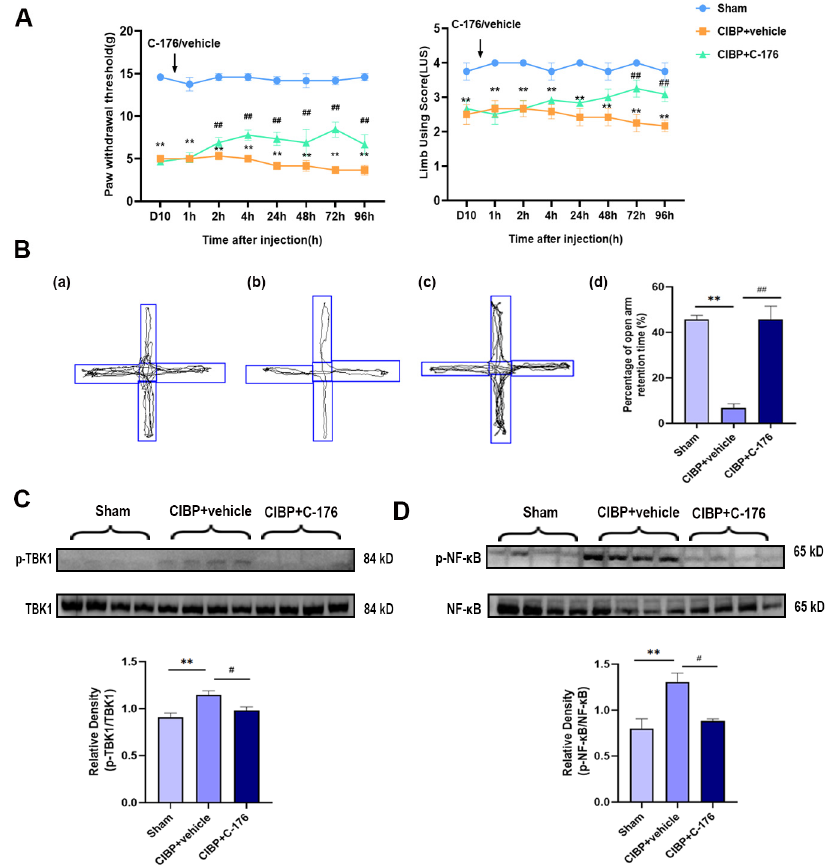
Figure 3. C-176 treatment relieved pain and pain-related anxiety by inhibiting the TBK1-NF- κ B signaling pathway in the mPFC of CIBP rats. ( A ) Compared with vehicle (corn oil, 200 µ L, i.p.), injection of C-176 (5.25 µ mol in 200 µ L corn oil, i.p.) significantly decreased the level of the paw withdrawal threshold (PWT) (Left) and limb use score (Right) of CIBP rats. ( B ) The tracks and analysis of elevated plus-maze experiment. Representative activity traces of sham ( a ), CIBP + vehicle ( b ), and CIBP + C-176 ( c ) in the elevated plus-maze experiment are shown. ( d ) Percentage of open arm retention time was analyzed’, n = 3. ( C ) The protein expression of the rate of p-TBK1/TBK1 in sham, CIBP + vehicle, and CIBP + C-176 group were determined using Western blots. ( D ) The protein expression of the rate of p-NF- κ B/NF- κ B in sham, CIBP + vehicle, and CIBP + C-176 group were determined using Western blots. GAPDH was detected as an internal control. Data are expressed as mean ± S.E.M., n = 4. ** p < 0.01 vs. sham, # p < 0.05, ## p < 0.01 vs. CIBP + vehicle. Full pictures of the Western blots are presented in Supplementary Materials.